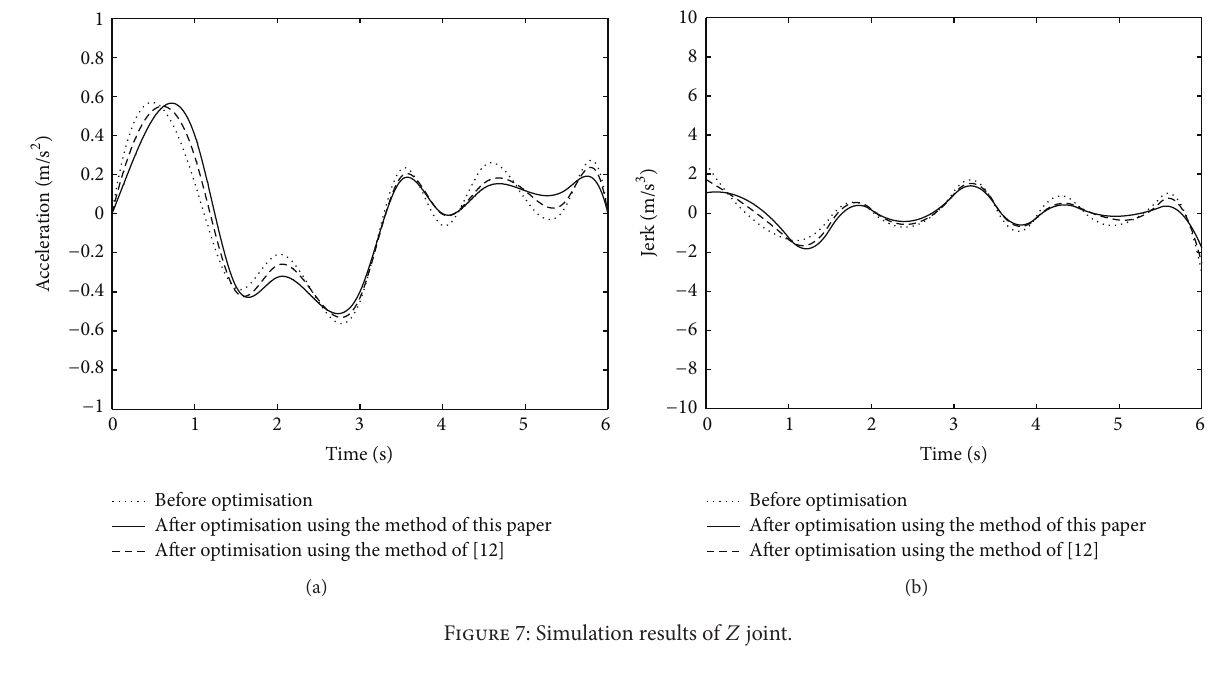
Figure 7: Simulation results of 𝑍